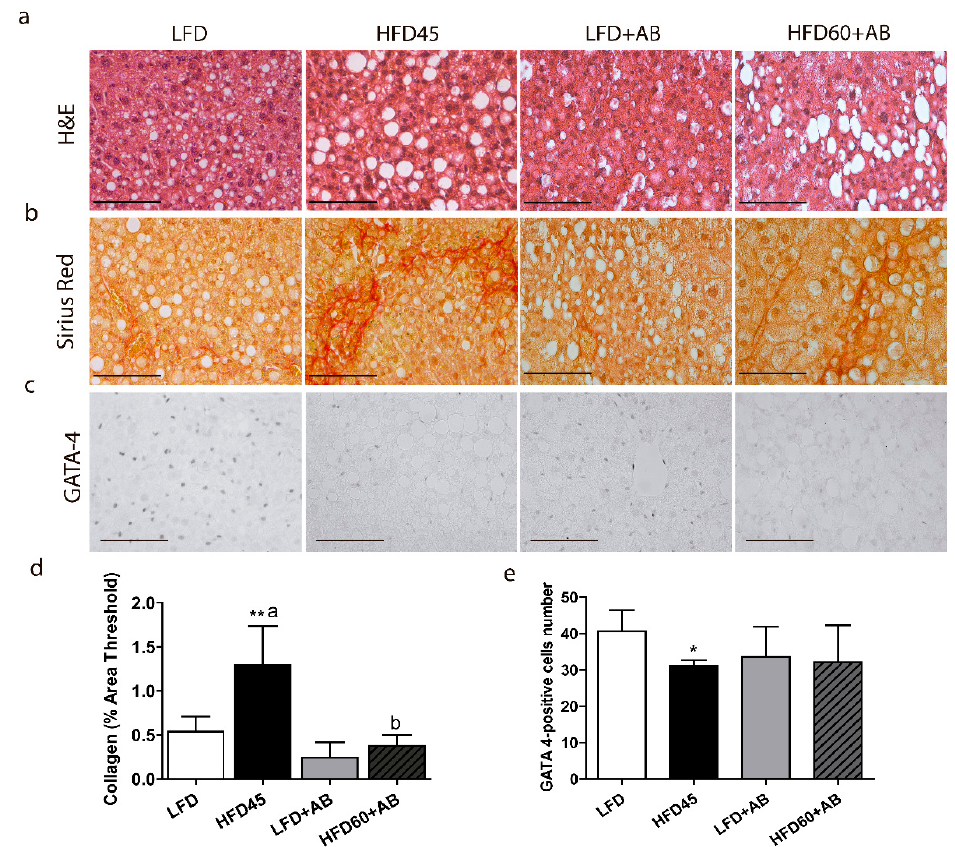
Figure 3. Histological analysis of liver injury induced by the HFD-L diets in LDLR -/- mice after 12 weeks of nutritional intervention with AB extract. Representative liver sections of ( a ) H&E staining, ( b ) Sirius Red staining, and ( c ) GATA4 HRP-immunostaining (40×, scale bar = 100 µm); ( d ) percent areas of hepatic collagen fibers stained with Sirius Red; ( e ) quantification of GATA4-positive cells. All data are shown as the means ± SD ( n = 5). * p ≤ 0.05/** p ≤ 0.01 vs. LFD. Different letters indicate significant differences among the HFD groups ( p ≤